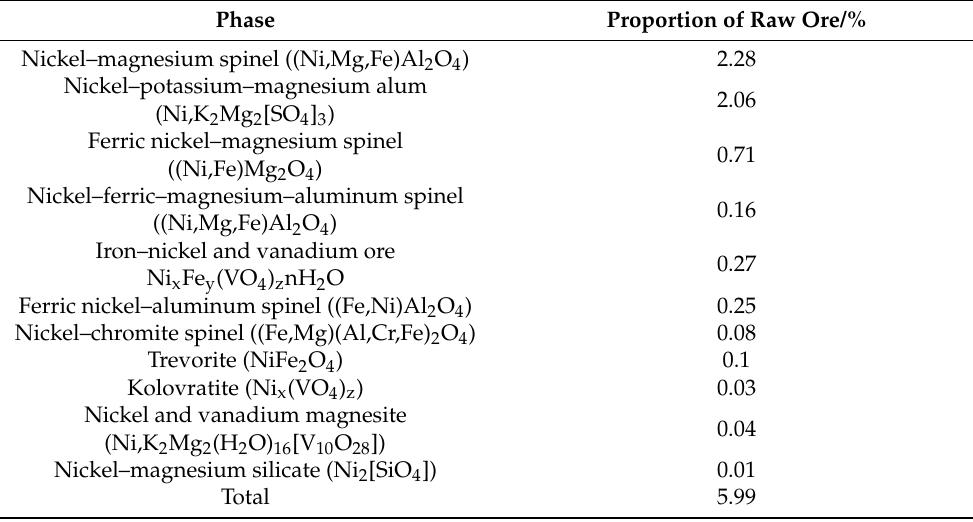
Table 6. Main nickel minerals in raw ore. Phase Proportion of Raw